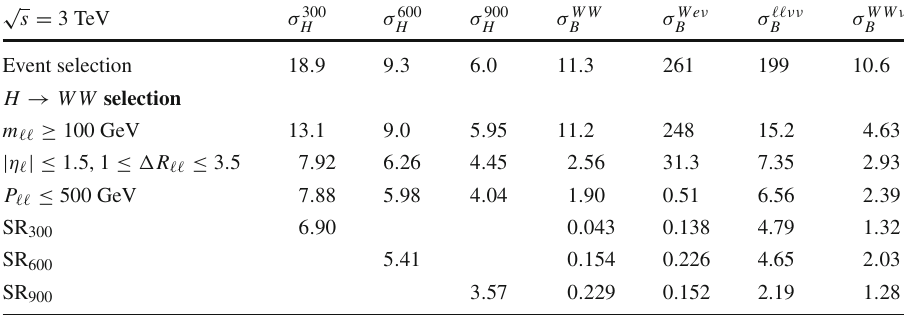
SM backgrounds e + e − → WW (grey), e + e − → e ± ν W ∓ (red), e + e − → WW νν (yellow) and e + e − → (cid:2)(cid:2)νν (green), for TeV CLIC